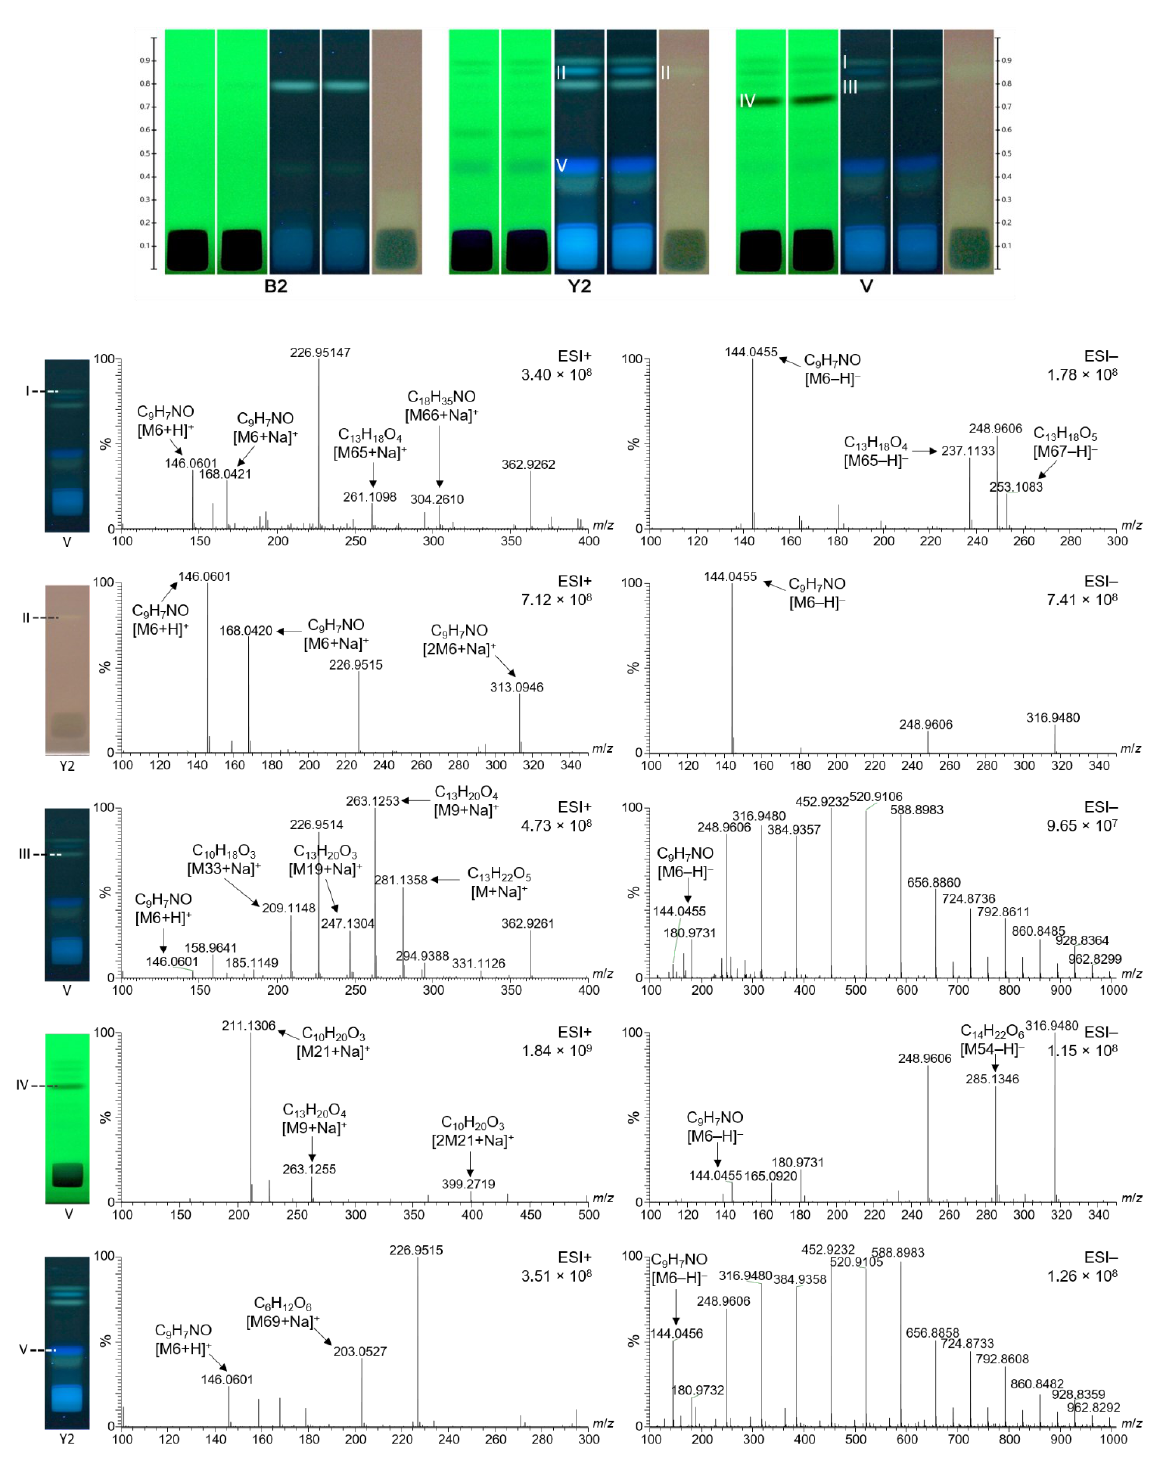
Figure 6. On-surface extraction and separation on the same plate: HPTLC chromatograms of Becium grandiflorum (B2), Coffea arabica from Yayu (Y2), and Vernonia amygdalina (V) honey extracts (25 µL each, note that here the start area focusing was skipped) at UV 254 nm, FLD 366 nm, and at white light illumination after the DPPH• scavenging assay, separated on HPTLC silica gel 60 F 254 plates with toluene–ethyl acetate–formic acid–water 2:6:1:0.6, V / V/V / V, and HPTLC–HESI–HRMS spectra in the positive and negative ionization mode of selected zones (for orientation, marked with Roman numerals, as the separation system is different to previous ones).